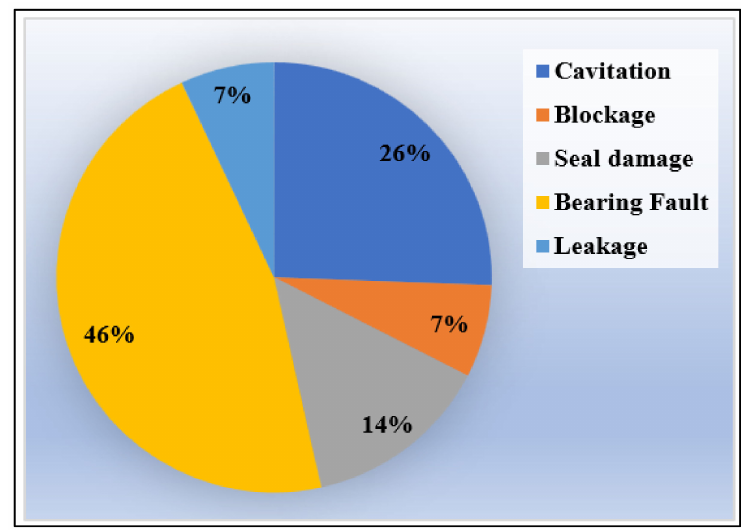
Figure 19. The most frequent faults addressed in the